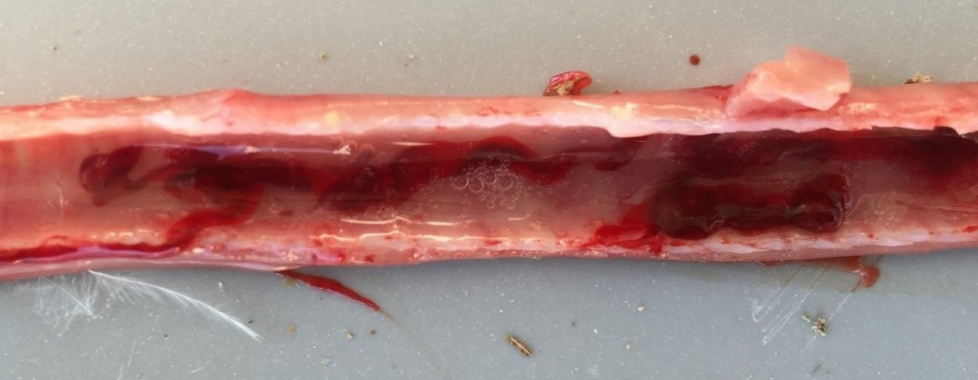
Figure 2. The trachea of a 33-day-old broiler chicken with typical symptoms of ILT, where hemorrhage and congestion of the trachea are visible, accompanied by bloody mucoid exudate in the